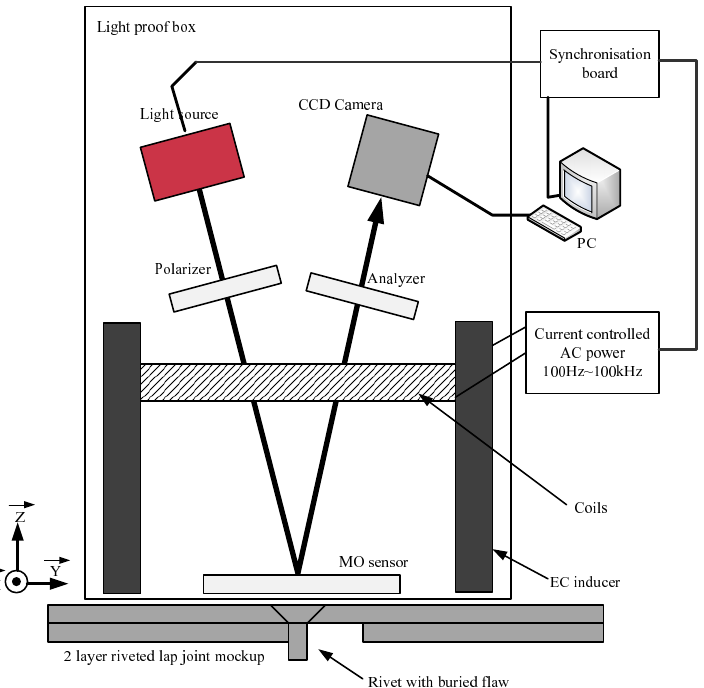
Figure 34. Schematic of the linear MO imager